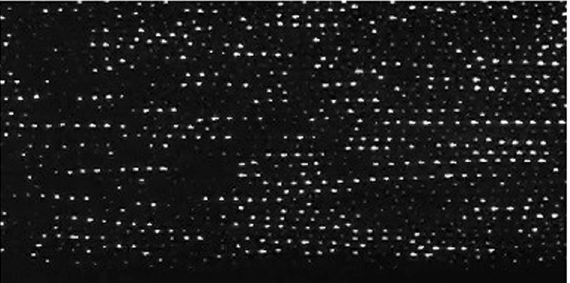
Fig. 5 String formation. The micropartcles arrange in strings in the presence of an external electric fi eld.